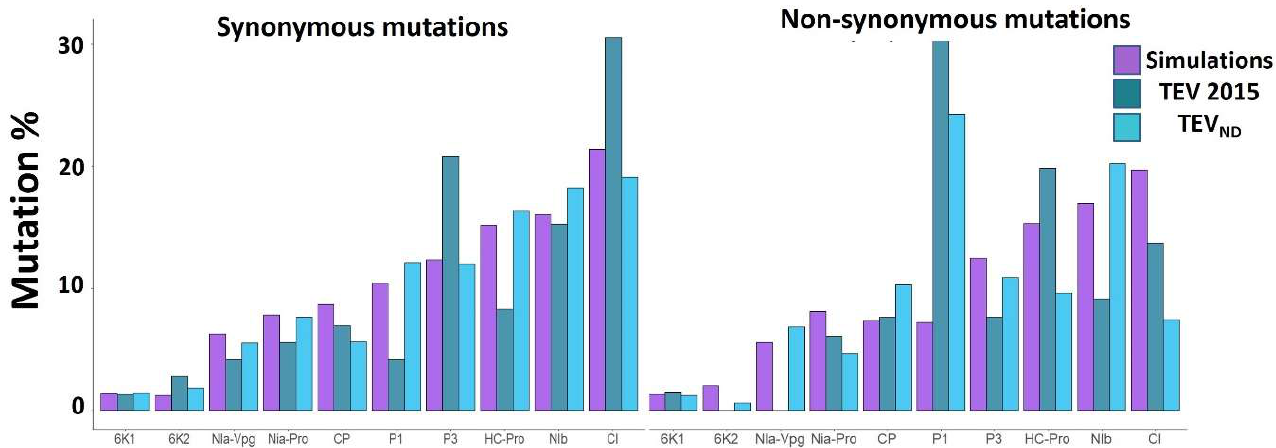
Figure 2. Mutation % in the TEV proteins from the experimental evolution [13], natural diversity and simulations. For PVY and TuMV, please refer to the supplemental data. The proteins are sorted from the smallest to the largest, left to right: 6K1, 6K2, Nia-VPg, Nia-Pro, CP, P1, P3, Hc-Pro, Nib, and CI. % mutation = (number of NS or S mutation within each protein)/(total number of NS or S mutations within the whole genome).